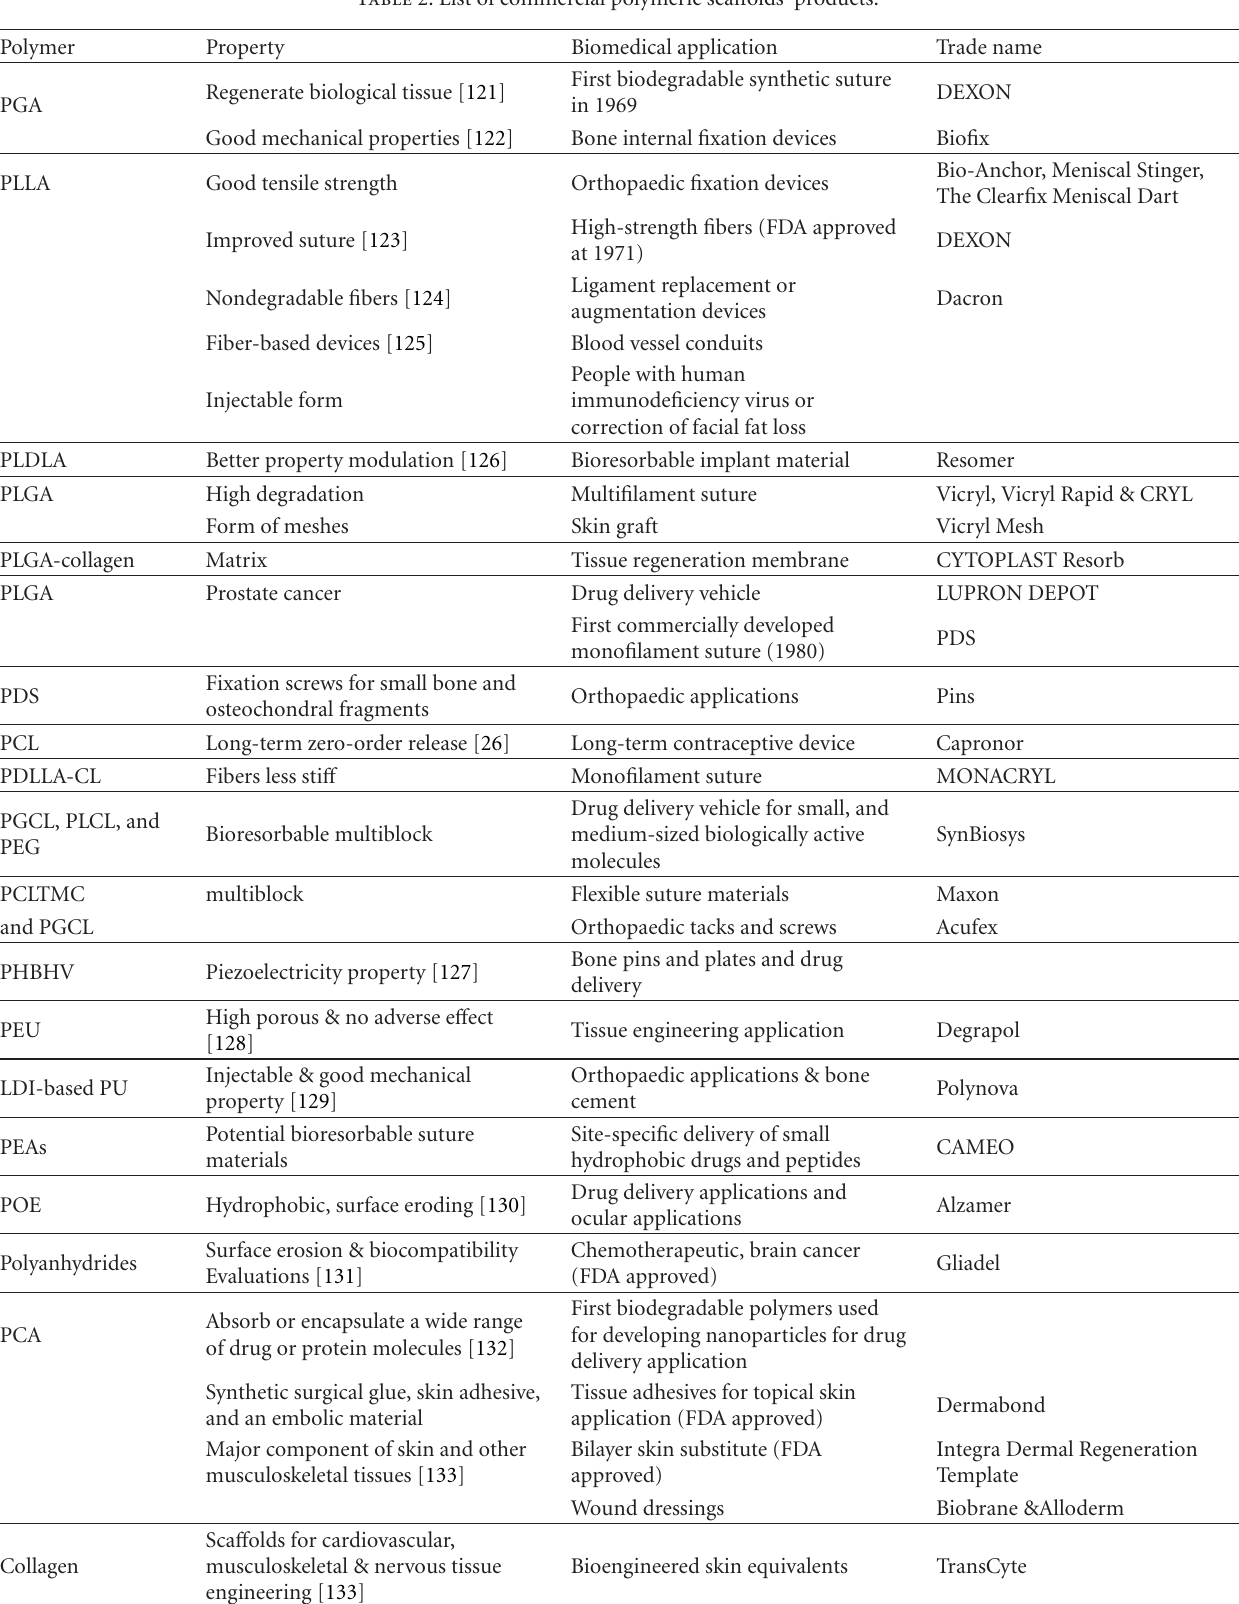
Table 2: List of commercial polymeric sca ff olds’